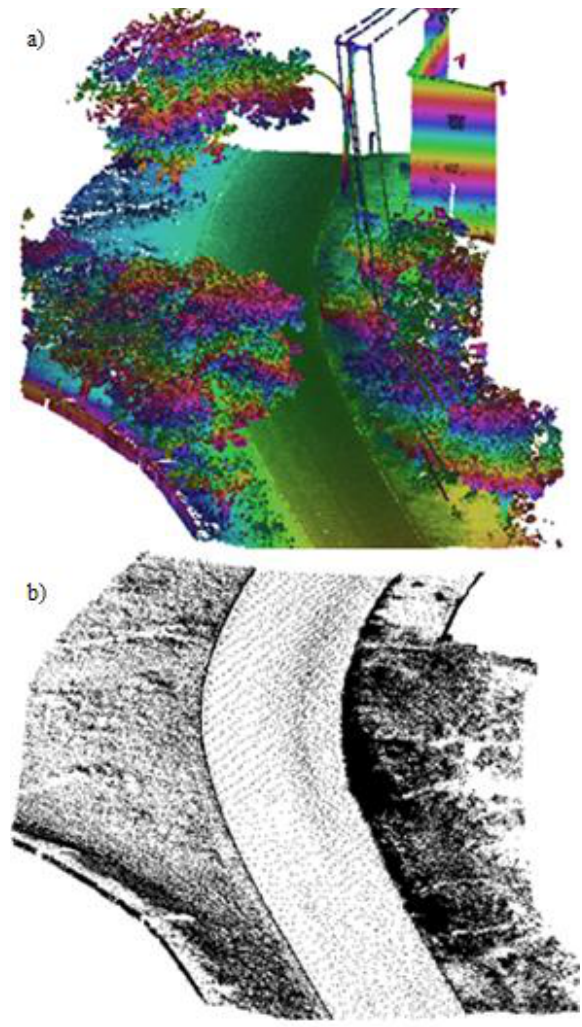
Figure 8. a) Point cloud example colored by height b) Resulting